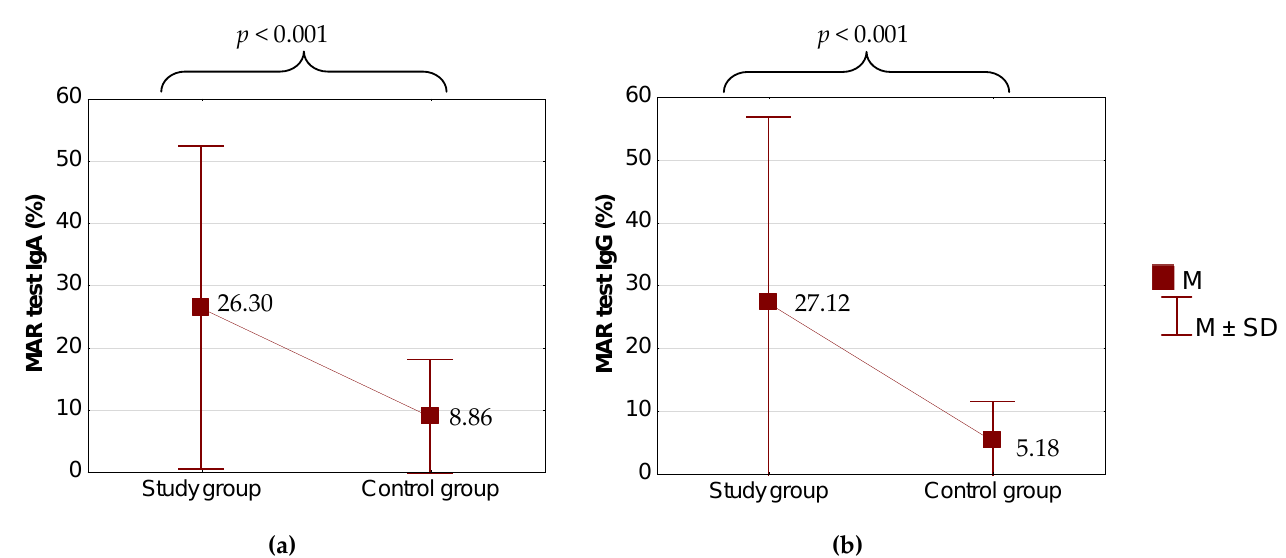
Figure 1. Comparison of MAR IgA ( a ) and IgG ( b ) between the study group and the control group. p for Student’s t -test.